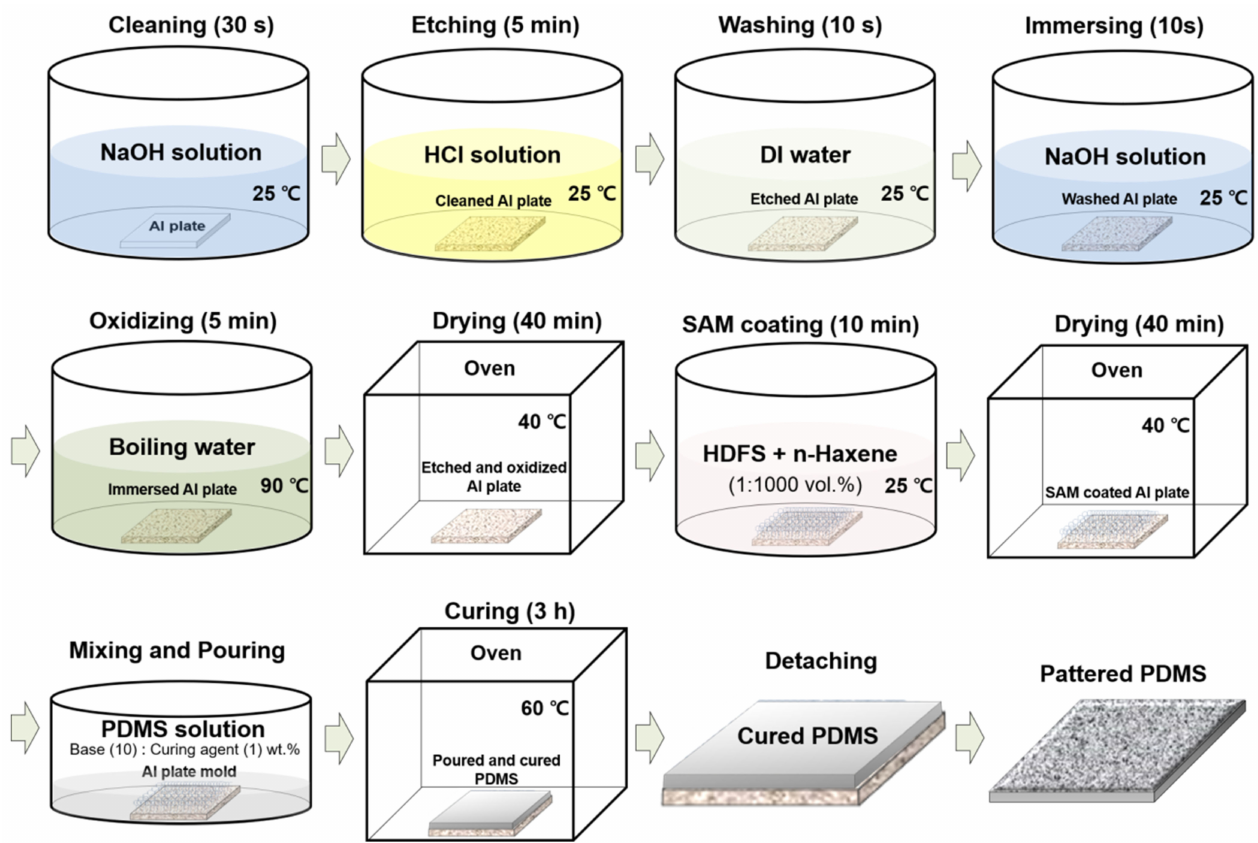
Figure 1. Fabrication process of micro/nanopatterned